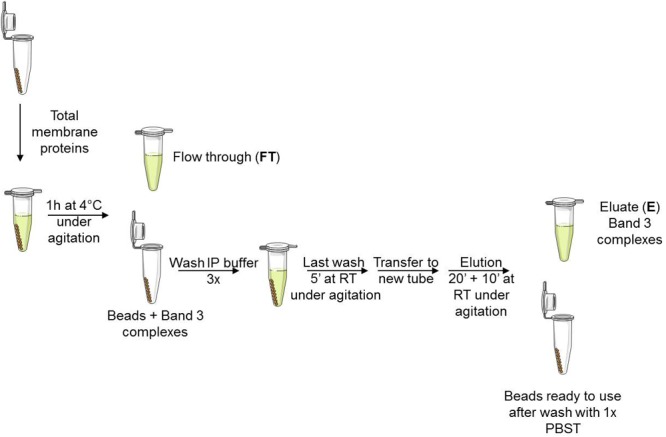
Workflow for Co-IP of band 3 complexes. Magnetic beads were covalently coated with anti-band 3 antibodies (BRIC 6 and 170 specific to internal and N-ter band 3 sequence, respectively). Membrane proteins were extracted with 1% DC buffer. Beads were previously equilibrated with 1x IP buffer. Wash buffer: 1x IP buffer, Last wash buffer: 0.5 M NH4OAc, 0.5 mM MgCl2, 0.1% Tween-20. Elution buffer: 0.5 M NH4OH, 0.5 mM EDTA. Beads were finally washed with 1x PBST and saved at 4°C for further co-IPs.